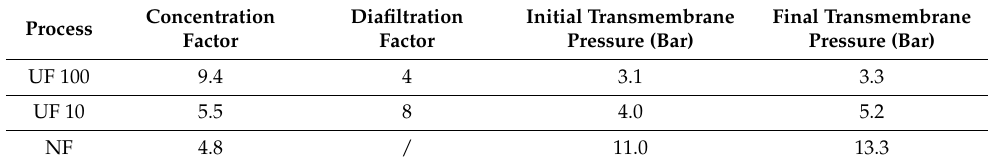
Table 1. Parameters used during filtration processes.